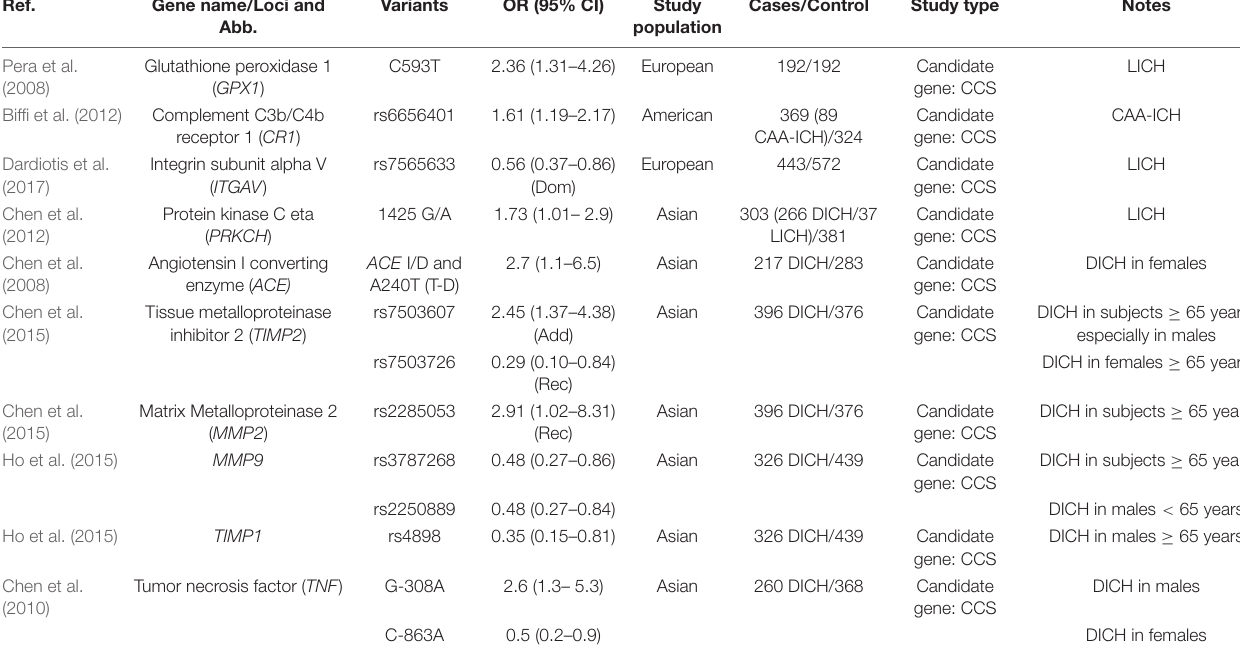
CCS, case control study; Dom, dominant; Rec, recessive; Add, additive; LICH, lobar spontaneous intracerebral hemorrhage; DICH, deep spontaneous intracerebral hemorrhage; CAA-ICH, cerebral amyloid angiopathy-related intracerebral hemorrhage; Ref., reference; Abb., Abbreviation; OR, odds ratio.